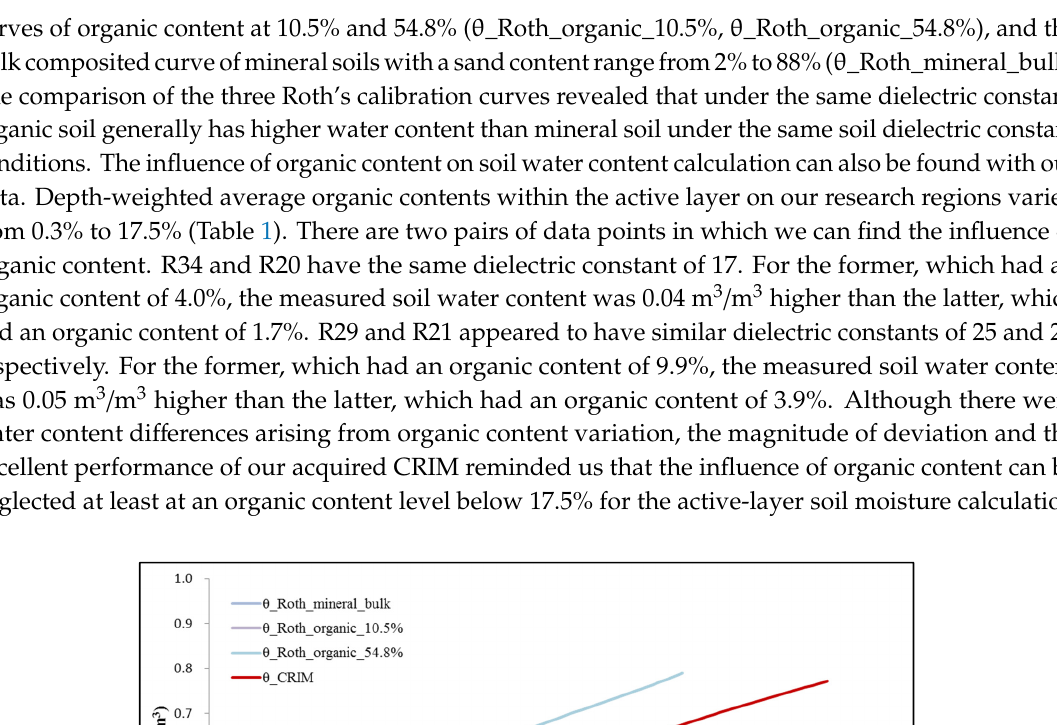
Figure 12. Active-layer soil organic content variation on the Qinghai–Tibet plateau.